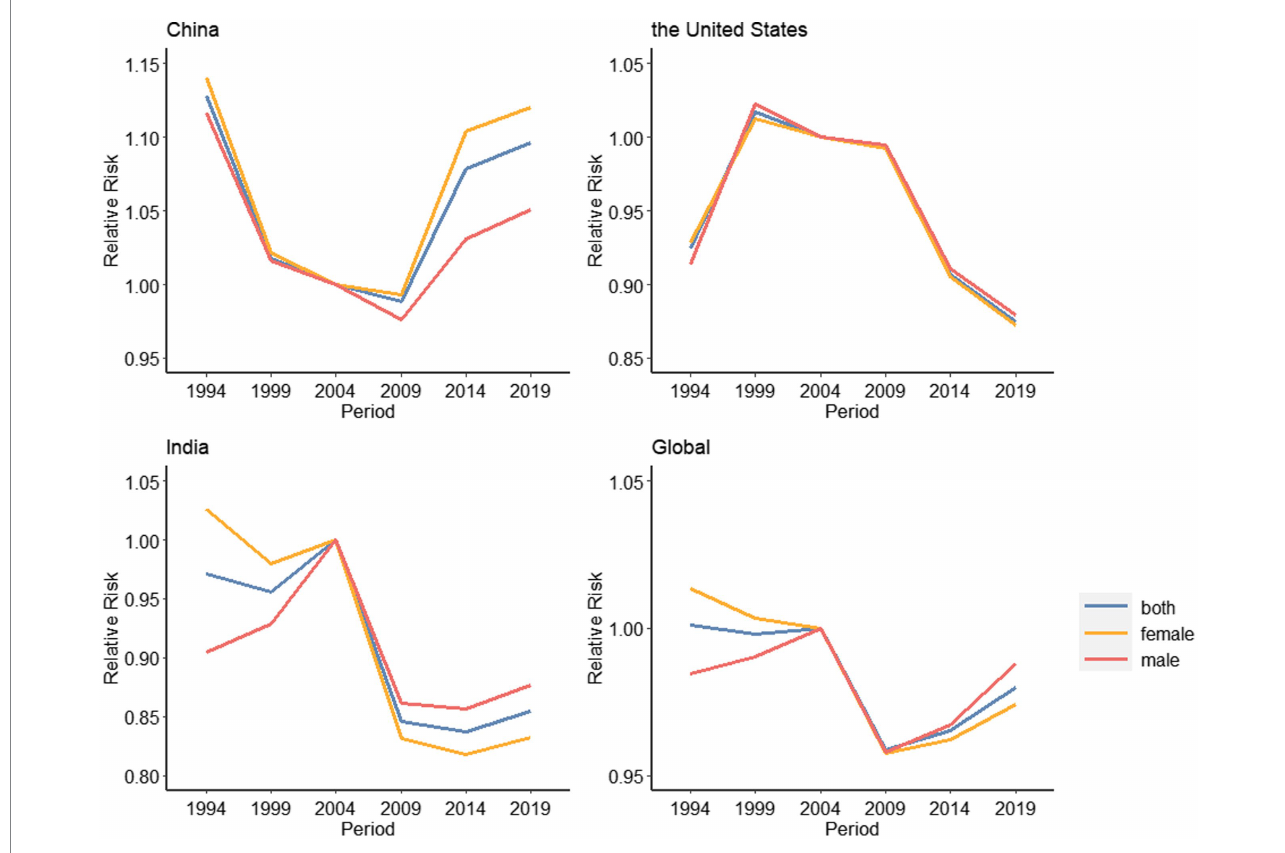
FIGURE 6 Period effects on depressive disorders incidence rate for China, the United States, India and the global,